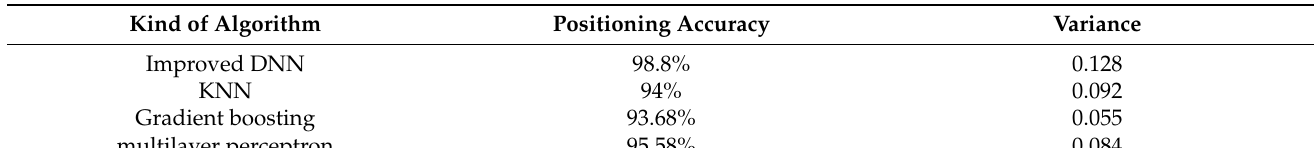
Table 5. Algorithm accuracy at the core point.